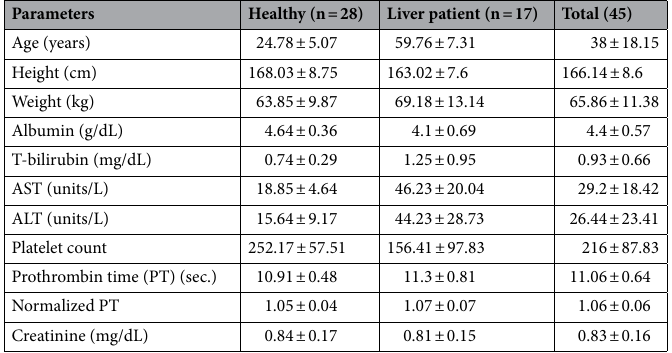
Table 1. Demographic and clinical parameters of study subjects (mean ±